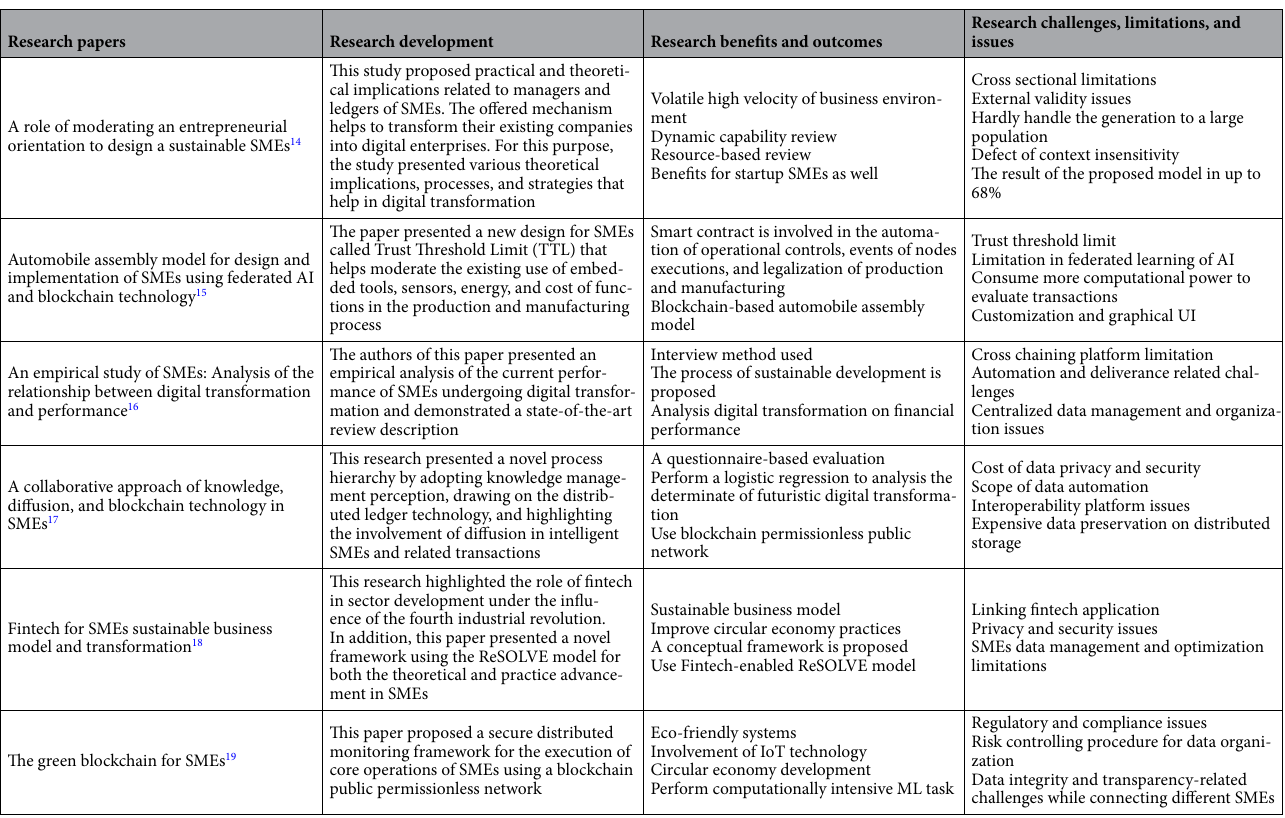
Table 1. Blockchain, AI, IIoT-enabled SMEs related